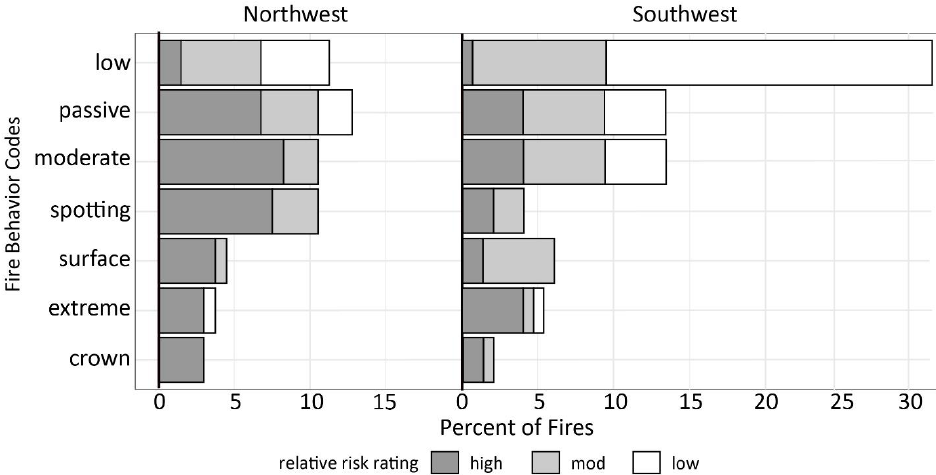
Figure 6. The frequency of fire behavior codes by relative risk ratings for the Northwest and Southwest geographic areas.